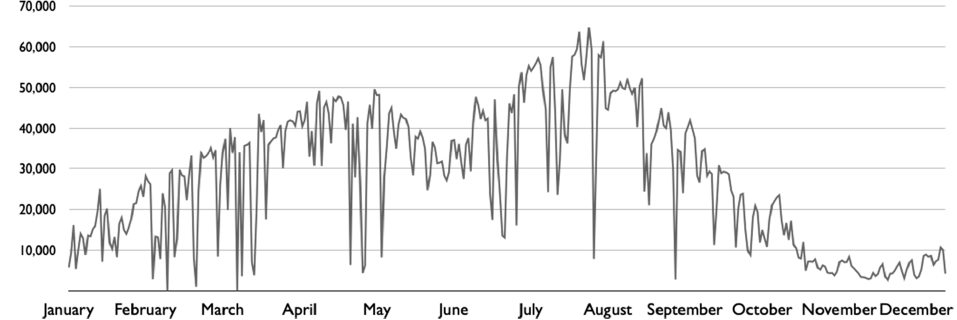
Figure 3. Daily bike sharing trips of Seoul in 2018. Data source: Seoul Open Data Plaza (https: // data.seoul.go.kr /